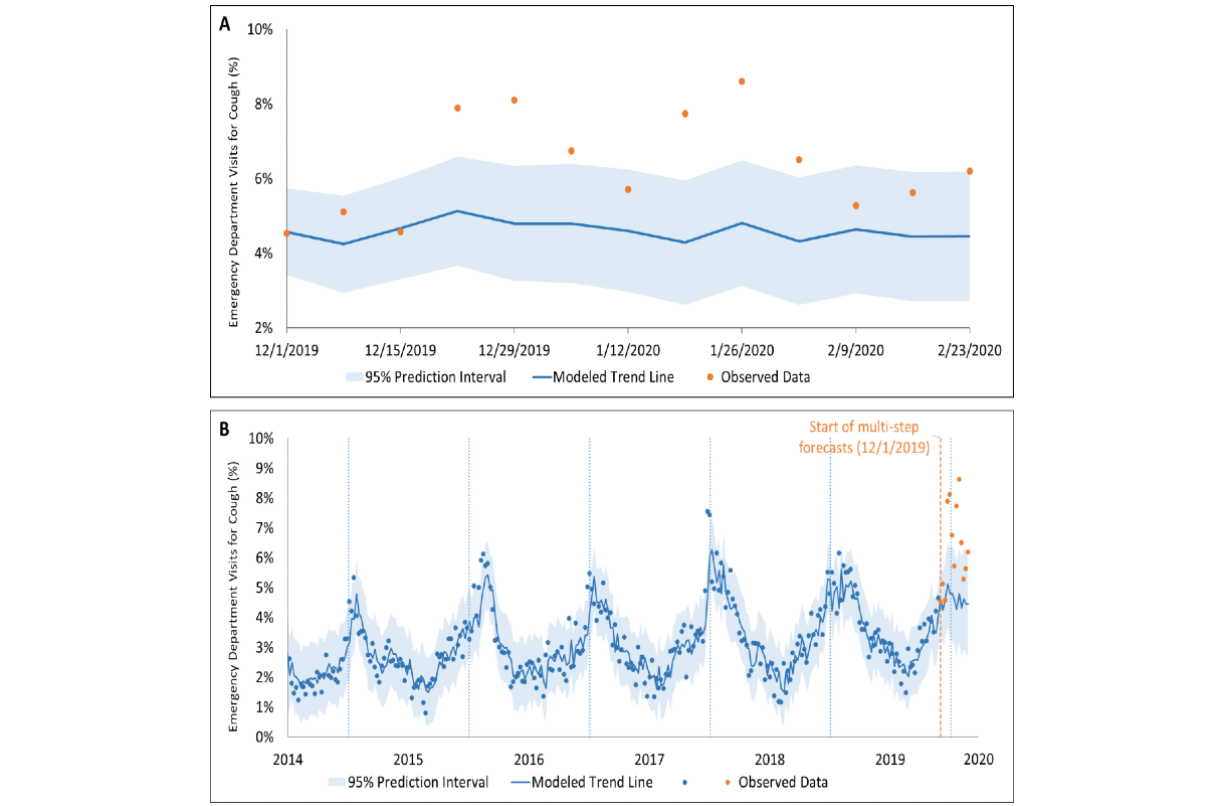
Figure 3. Time-series analysis of emergency department visits for cough. (A) Forecast, with 95% prediction intervals, of expected rates of emergency department presentations for cough (based on time-series analyses of the previous 5 years), with observed data for each week shown for December 1, 2019, to February 29, 2020. (B) Time-series analysis of emergency department